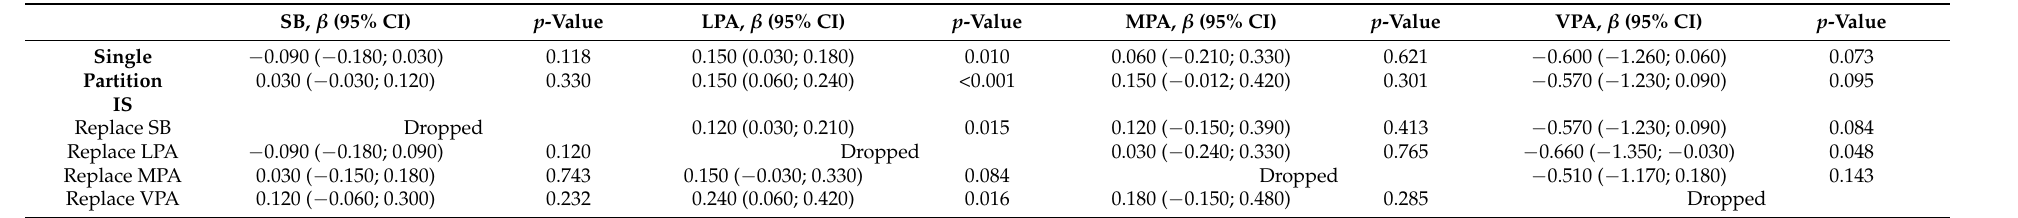
Table 3. Single, partition, and isotemporal substitution of each physical activity per 30-ninute/day increase and work efficiency (scores)